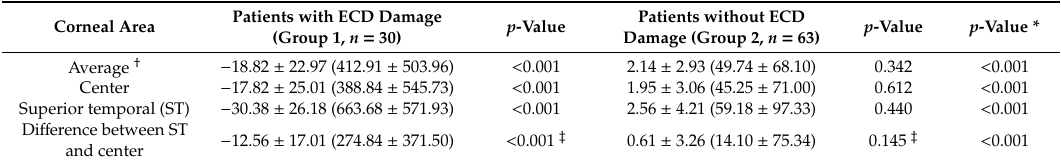
Table 3. Rate of postoperative change in corneal endothelial cell density (% / year). Patients with ECD Damage Corneal Area (Group 1, n =